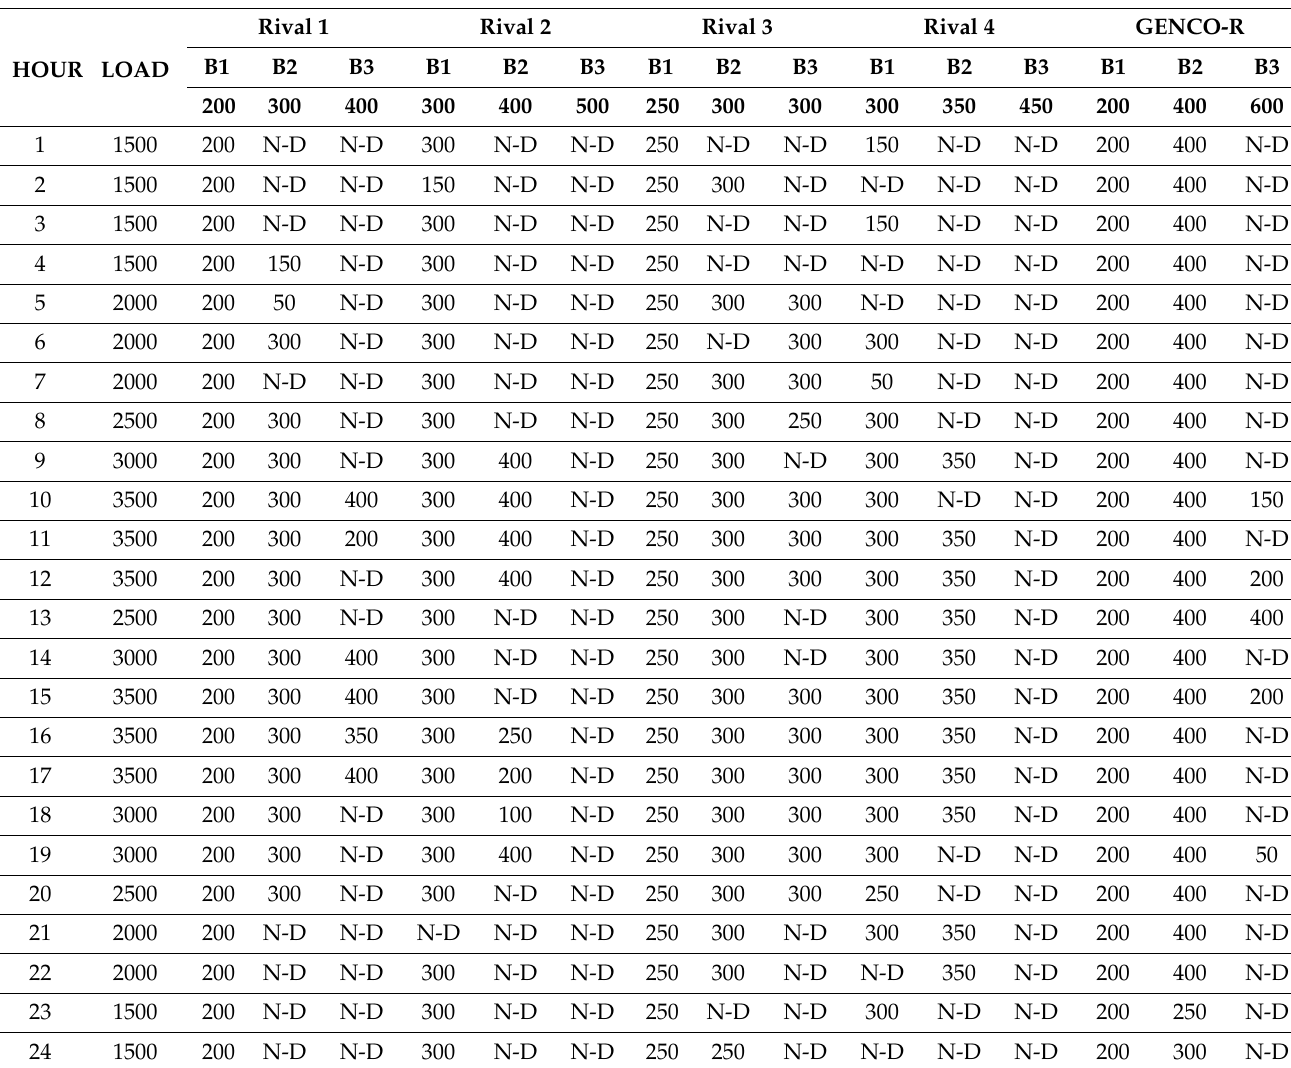
Table 9. Dispatch Obtained by Different Algorithms Using Normal Distribution for